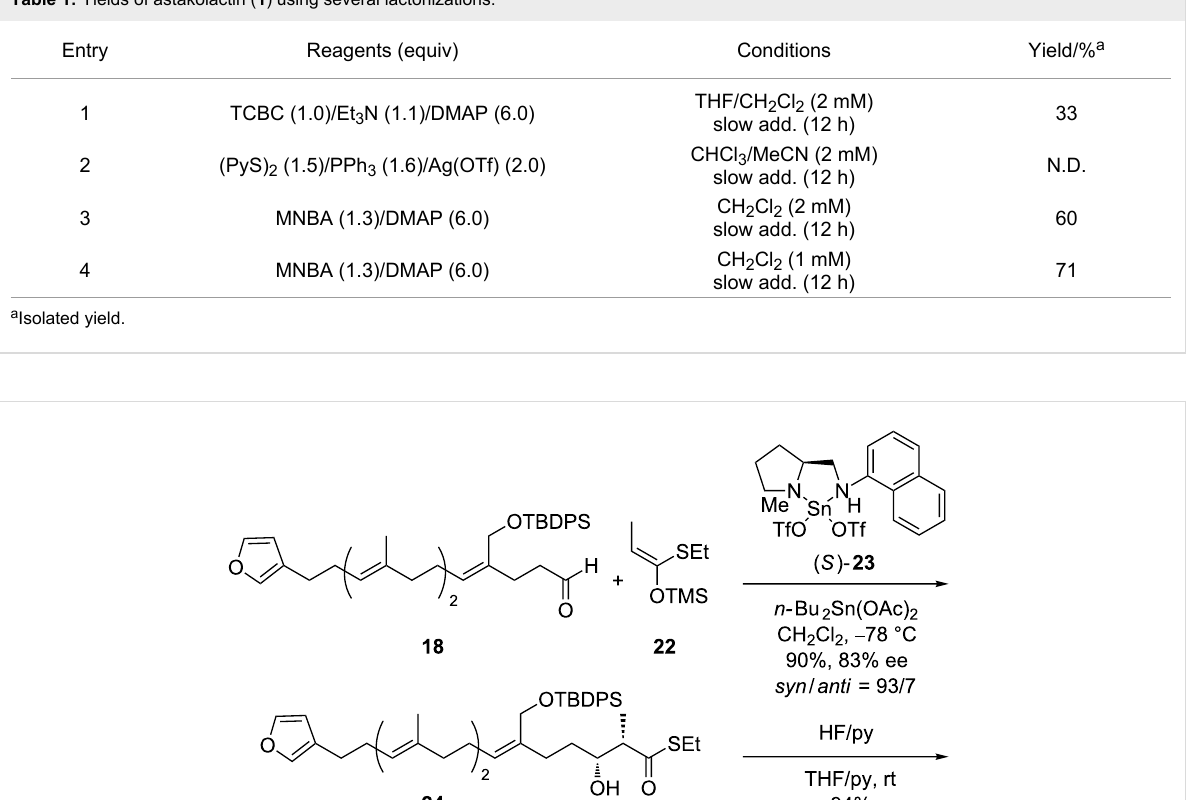
Table 1: Yields of astakolactin ( 1 ) using several